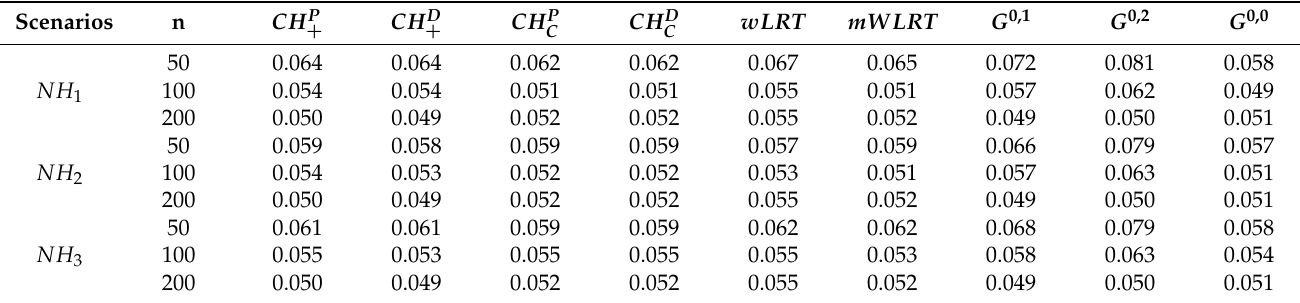
Table 2. Type I error